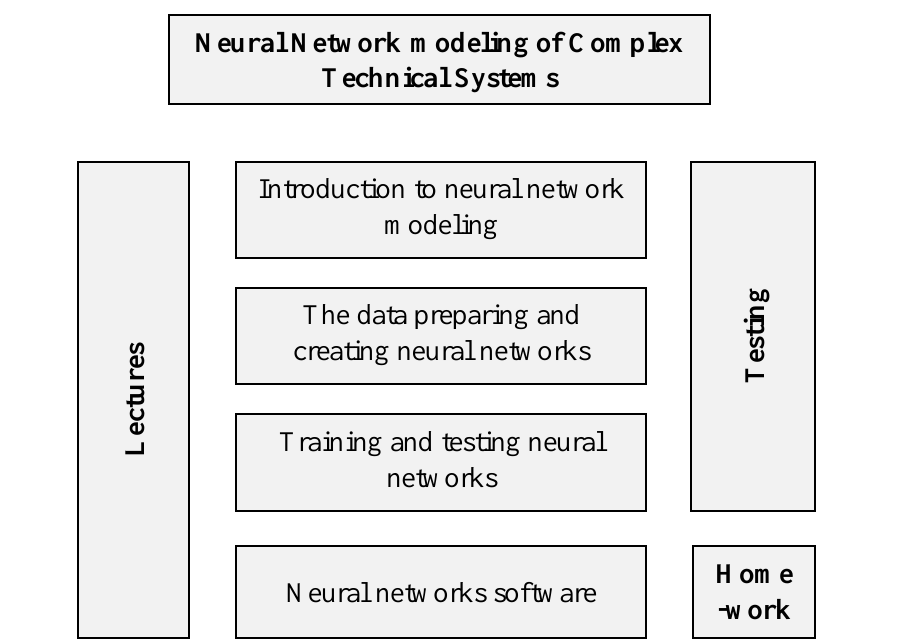
Fig. 1. “Neural Network modeling of Complex Technical Systems” online course